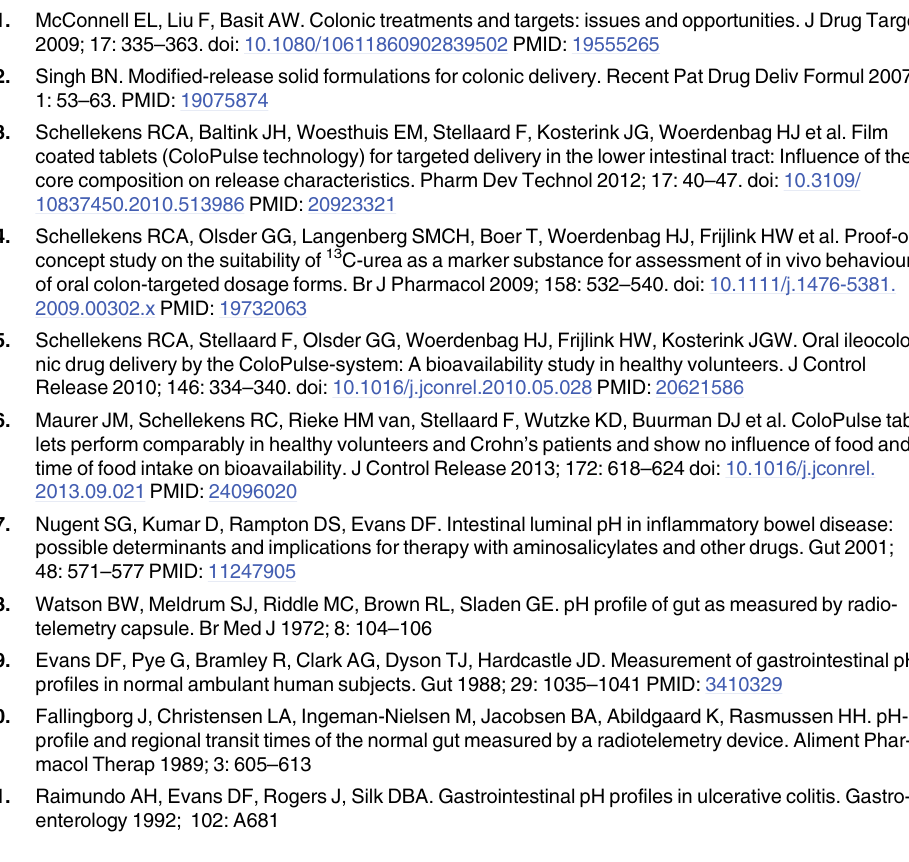
S1 Table. Summary results of all